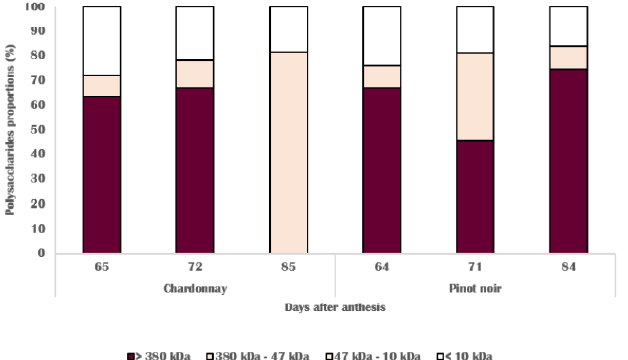
Figure 8. Proportions of pectic polysaccharides according to their molecular mass in strong bonds for Pinot noir and Chardonnay skin cell walls.